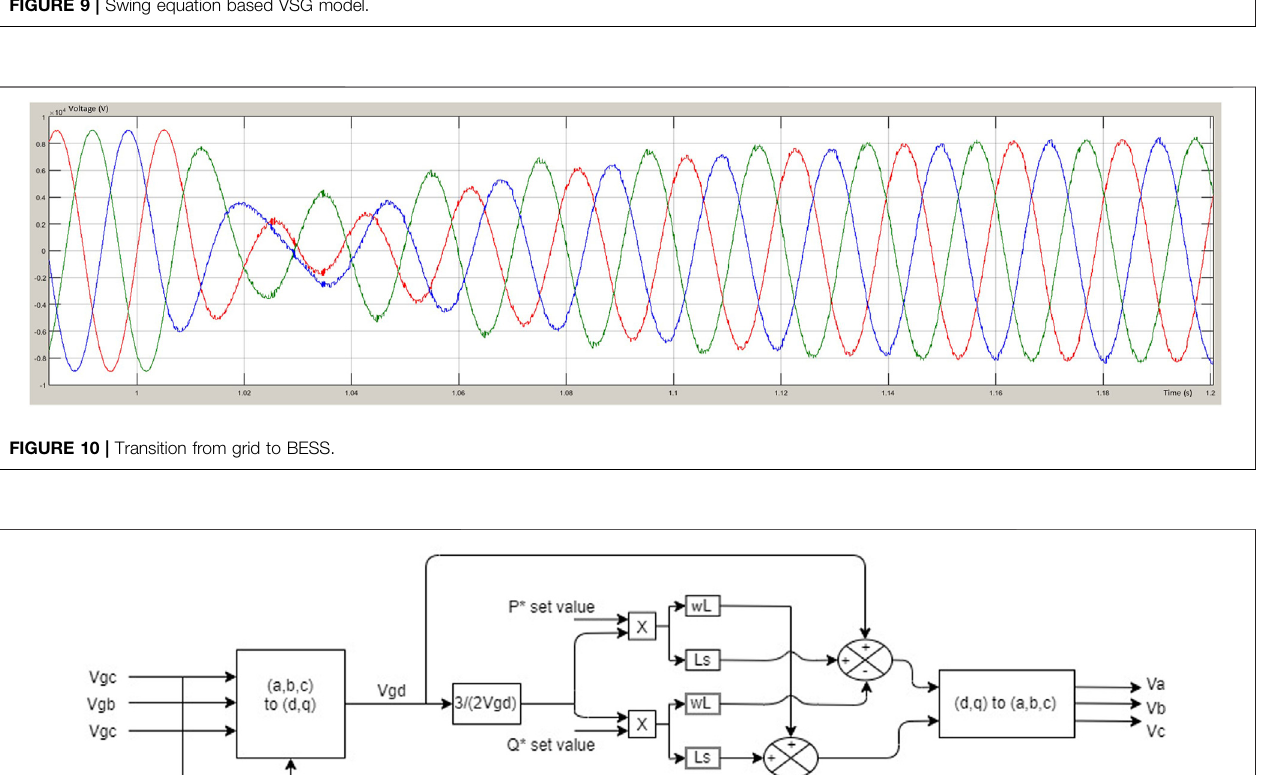
FIGURE 9 | Swing equation based VSG model.